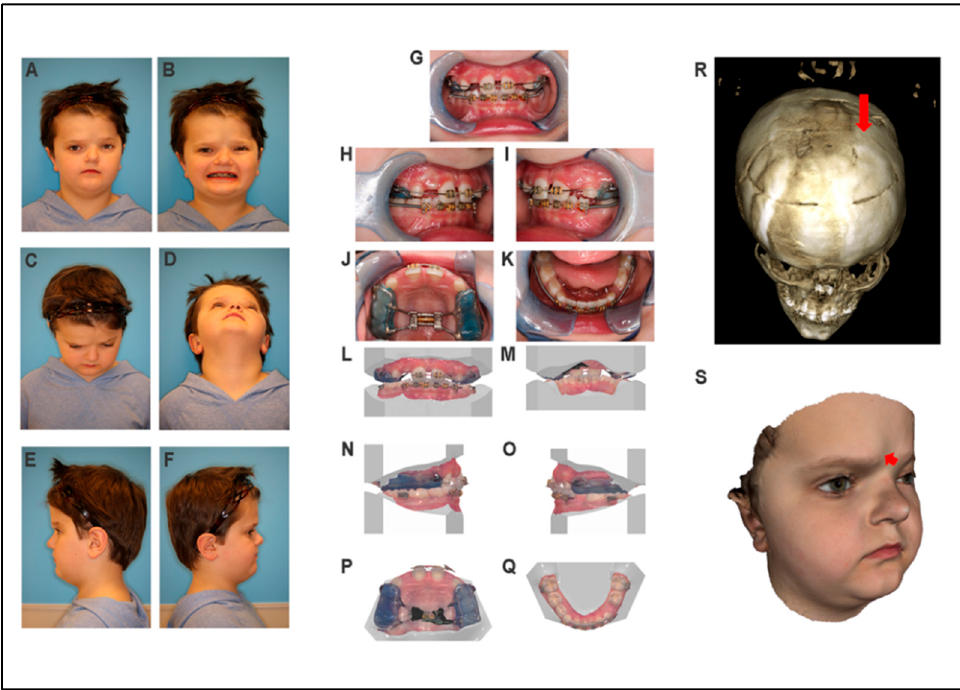
Figure 1. Clinical phenotype of a patient with Muenke syndrome (proband). ( A – F ) Two-dimen- sional photographs of the proband. ( G – K ) Intraoral photographs. ( L – Q ) Intraoral scan images. ( R ) Three-dimensional CBCT scan image. Red arrow shows the location of left craniosynostosis and repair. ( S ) Three-dimensional soft tissue image. Red arrow shows the frontal bossing.